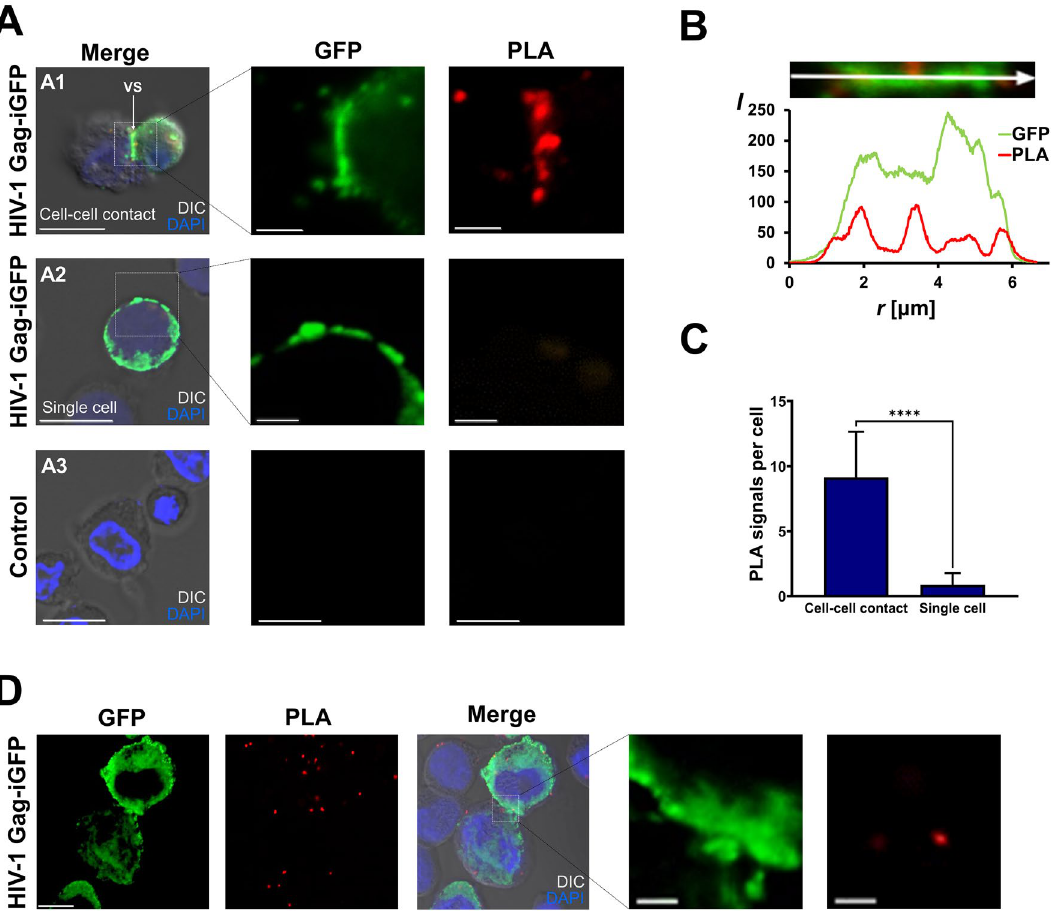
Figure 5. ( A ) Detection of interaction between CD63 and gp41 at the virological synapse (VS) between Jurkat cells expressing HIV-1 JR-FL Gag-iGFP by employing direct PLA against CD63 and 2F5 epitopes. The control contains Jurkat cells without HIV-1 JR-FL Gag-iGFP transfection. ( B ) Plot of fluorescence intensities for GFP and PLA signals along the VS (white arrow). ( C ) Quantification of PLA signals obtained for Jurkat cells with cell–cell contacts (n = 14) and for single cells without cell–cell contacts (n = 15). (D) Direct PLA against CD63 and 2F5 using HEK293T cells. All scale bars are 10 µm, except in cutouts, where they are 2